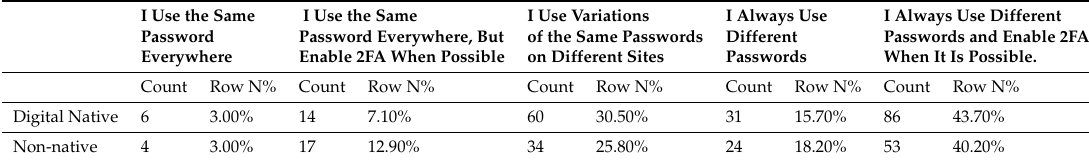
Table 10. Differences in password habits between